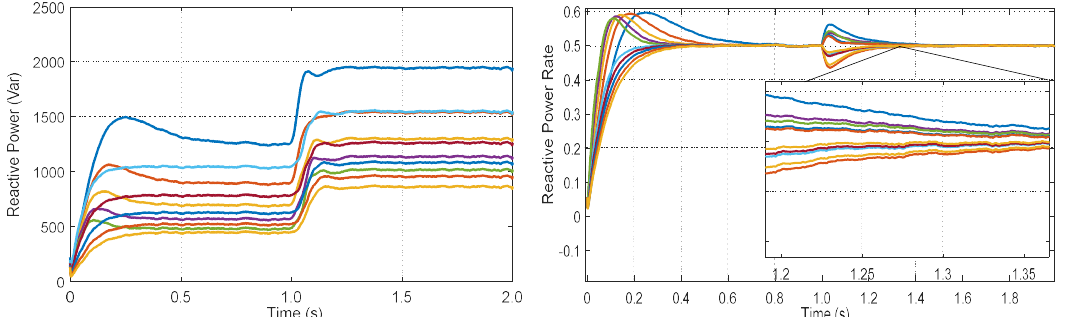
Figure 5. Reactive power output of 10 DGs with periodic communication